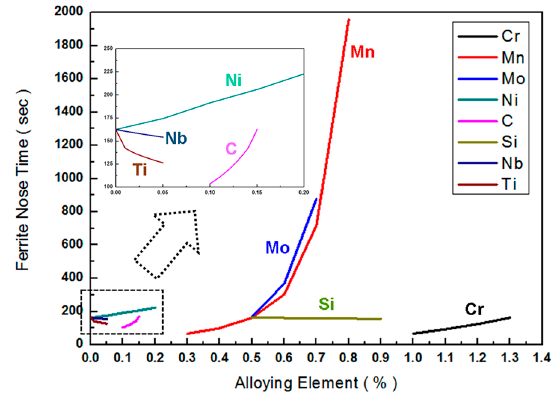
Figure 6. Effects of alloying elements on the ferrite nose time for the model A alloy.